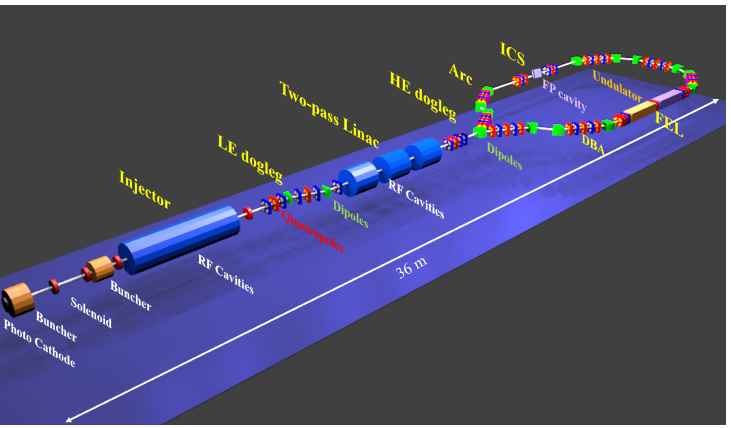
Figure 3. BriXSinO as an example of Paradigm (iii) with energy recovery (average electron beam current up to 8